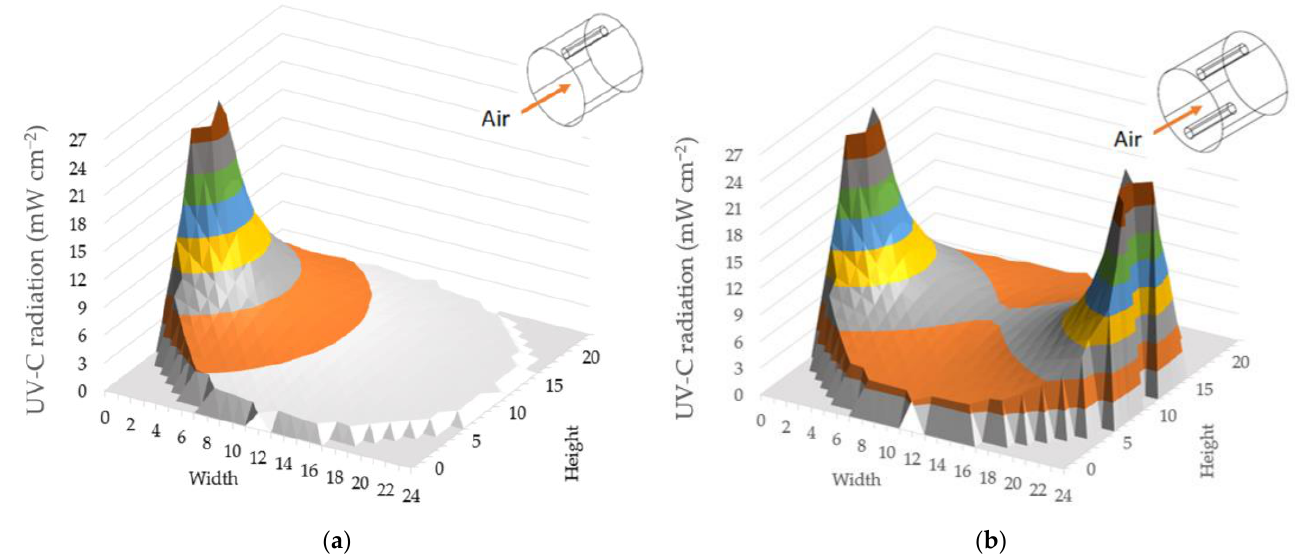
Figure 3. UV light intensity distribution of ( a ) one UV lamp; ( b ) two UV lamps.